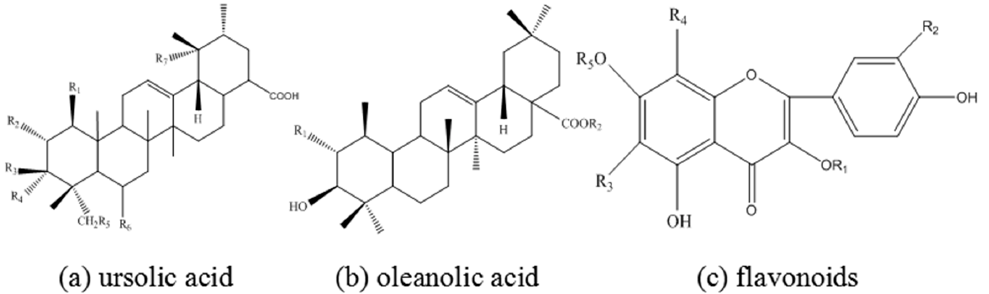
Figure 1. Molecular structures of ( a ) ursolic acid; ( b ) oleanolic acid; and ( c ) flavonoids.